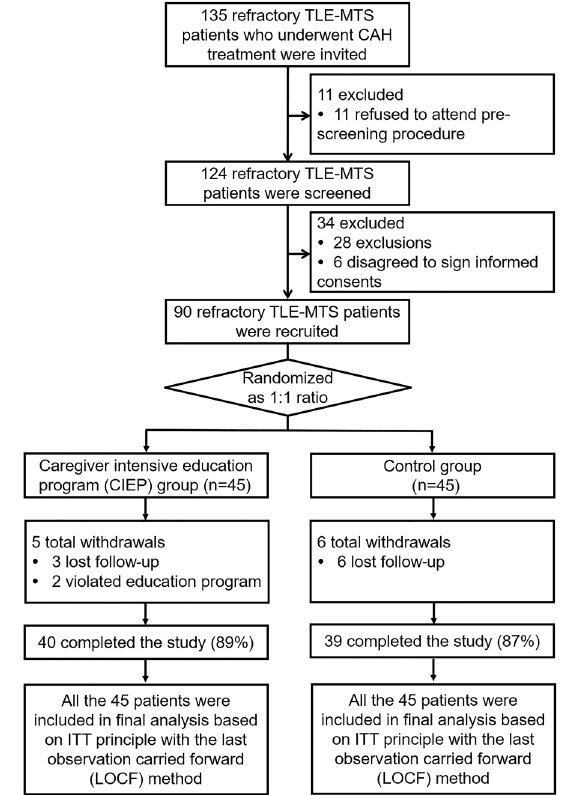
Figure 1. Study fl ow. TLE-MTS: temporal lobe epilepsy and mesial temporal sclerosis; CAH: cortico-amygdalohippocampec- tomy: ITT: